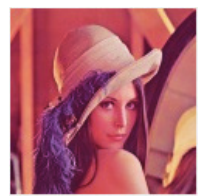
Fig. 1. Model image (size : 120 ×